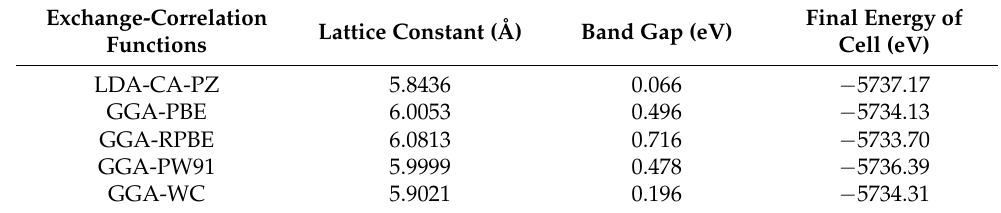
Table 1. The optimized result using different exchange-correlation functions.